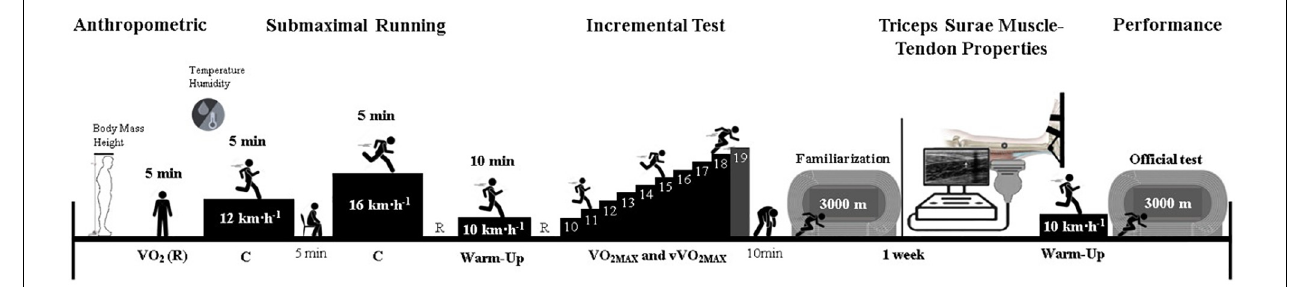
FIGURE 1 | Experimental design. C, metabolic cost of running; 3,000-m, 3,000-m running performance; ˙VO 2 , oxygen uptake; ˙VO 2 MAX , maximal oxygen uptake; v˙VO 2 MAX , speed associated with maximal oxygen uptake; R,